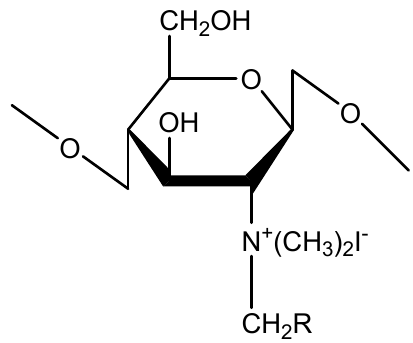
Figure 5. The chemical structure of N , N , N -trimethyl chitosan (TMC).